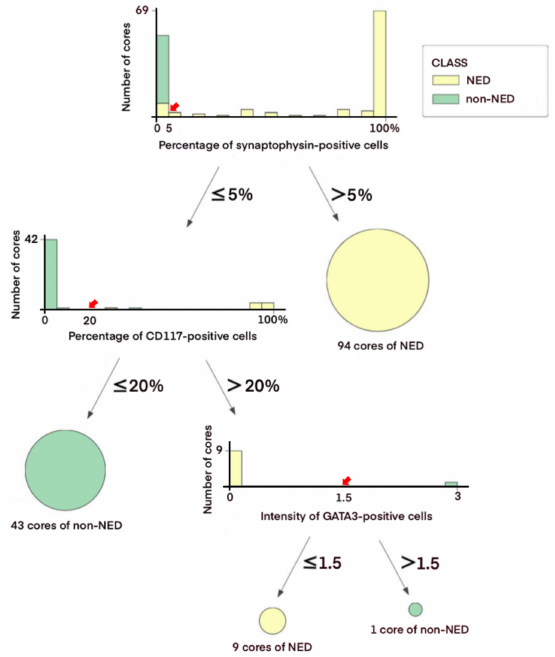
Figure 2. Decision tree model of the discovery cohort. Diagnostic flow of the training set is demon- strated with cutoff values (bold red arrow) and distribution plots of NED and non-NED cores. Each distribution plot stands for a split-by-condition node. The x -axis and y -axis represent the extent or intensity of the corresponding IHC marker and the number of NED or non-NED cores, respectively. The finally classified cores are colored yellow for NED and green for non-NED. The degrees of intensity of GATA3 are represented as follows: 0, negative; 1, weak; 2, moderate; 3,